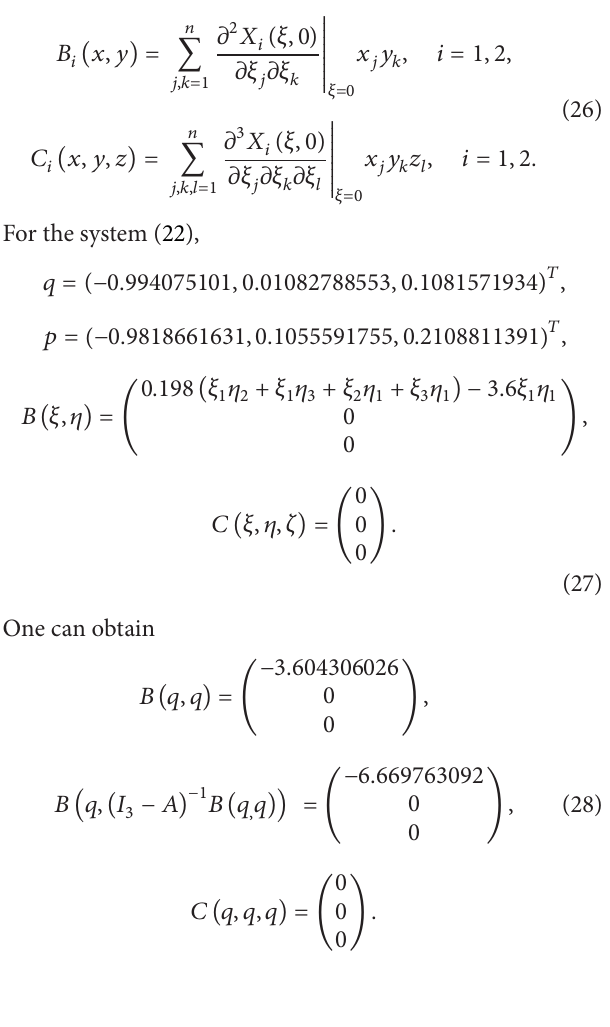
Figure 3: The Lyapunov exponent spectrum (blue, green, and red) and bifurcation of 𝑝 𝑥 (pinkish red) versus the parameters 𝑠 2 when = 0.4 . 𝑠 3 where 𝐼 3 is the unit 3 × 3 matrix, 𝐴𝑞 = −𝑞 , 𝐴 𝑇 𝑝 = −𝑝 , (𝐸 ) , ⟨𝑞, 𝑞⟩ = ⟨𝑝, 𝑞⟩ = 1 , ⟨, ⟩ denotes the inner 𝐴 = 𝐴 𝑝𝑏 1 product, and the multilinear functions 𝐵 and 𝐶 are defined, respectively,